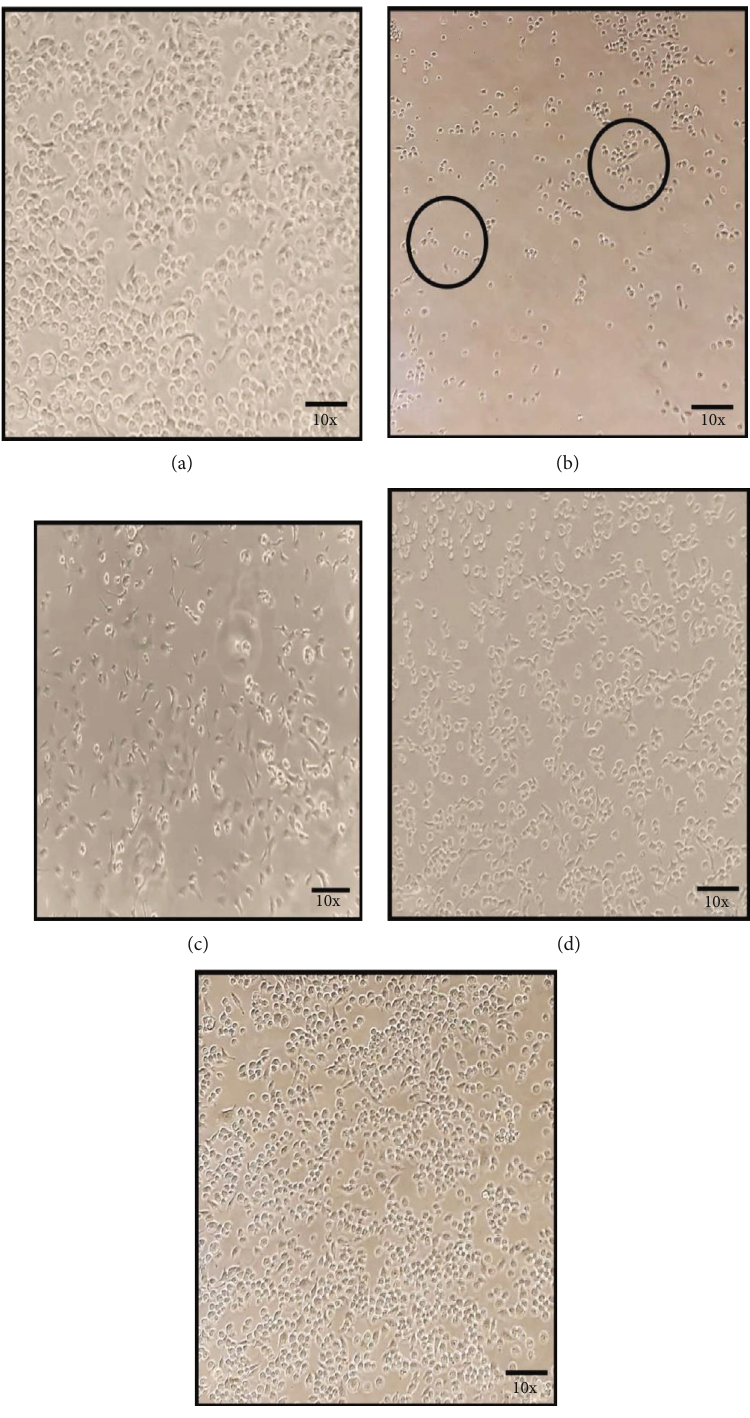
Figure 13: Microscopic images of RAW 264.7 cells treated with (a) control, (b) 100 mM ethanol control, (c) 100 mM ethanol+1 mM Met, (d) 100mM ethanol+10 μ l/ml probiotic V, and (e) 100 mM ethanol+10 μ l/ml probiotic V and 1 mM Met combination. The above fi gures are representative of 10x objective images of three di ff erent experiments. RAW 264.7 cells treated with ethanol alone or along with probiotic V and Met alone or in combination for 48 h. Ethanol-exposed RAW 264.7 cells showed increased cellular distortion. Co-treatment of ethanol with probiotic V and Met in combination showed improved cellular integrity with round-shaped morphology, similar to the control cells as compared to the ethanol-exposed RAW 264.7 cells. However, di ff erences were also observed between the individual treatment of either probiotic V and Met alone when compared with the combination treatment (i.e., probiotic V and